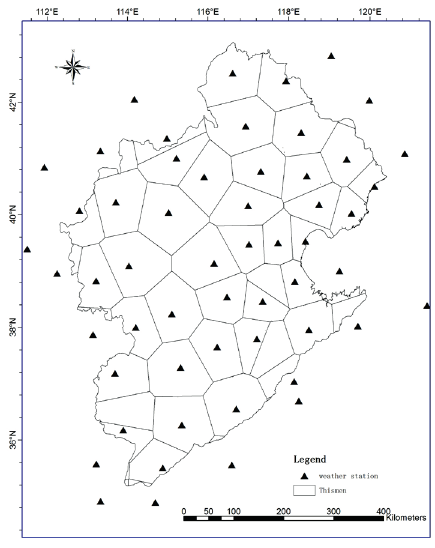
Fig. 1 Distribution of the weather stations.